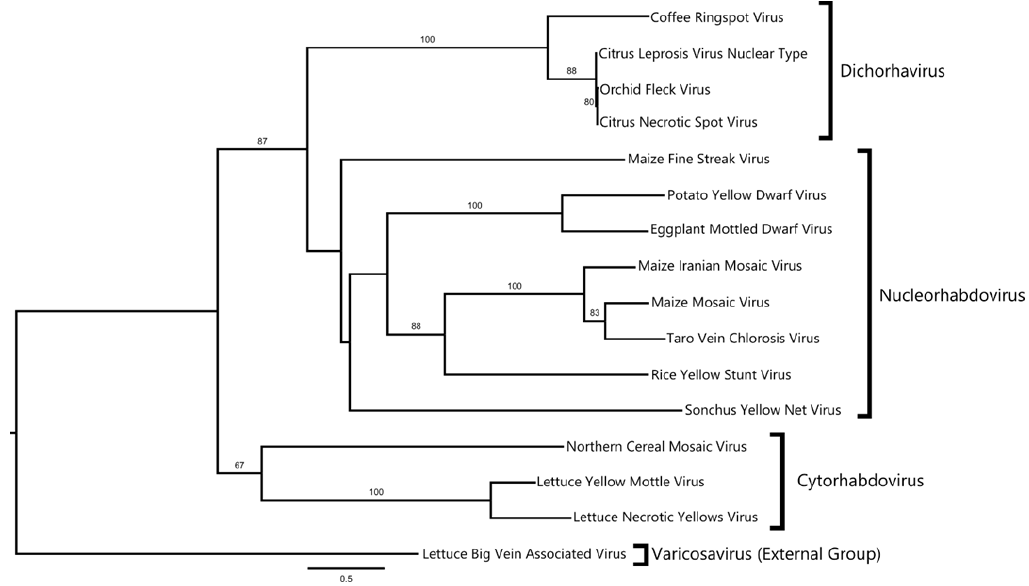
Figure 3. Phylogenetic reconstruction for nucleocapsid sequences. Tree construction is based on the maximum likelihood model with a bootstrap value indicated above supported branches. CNSV and Orchid Fleck Virus (OFV) and CiLV-N are grouped in a single branch, marked as Dichorhavirus.